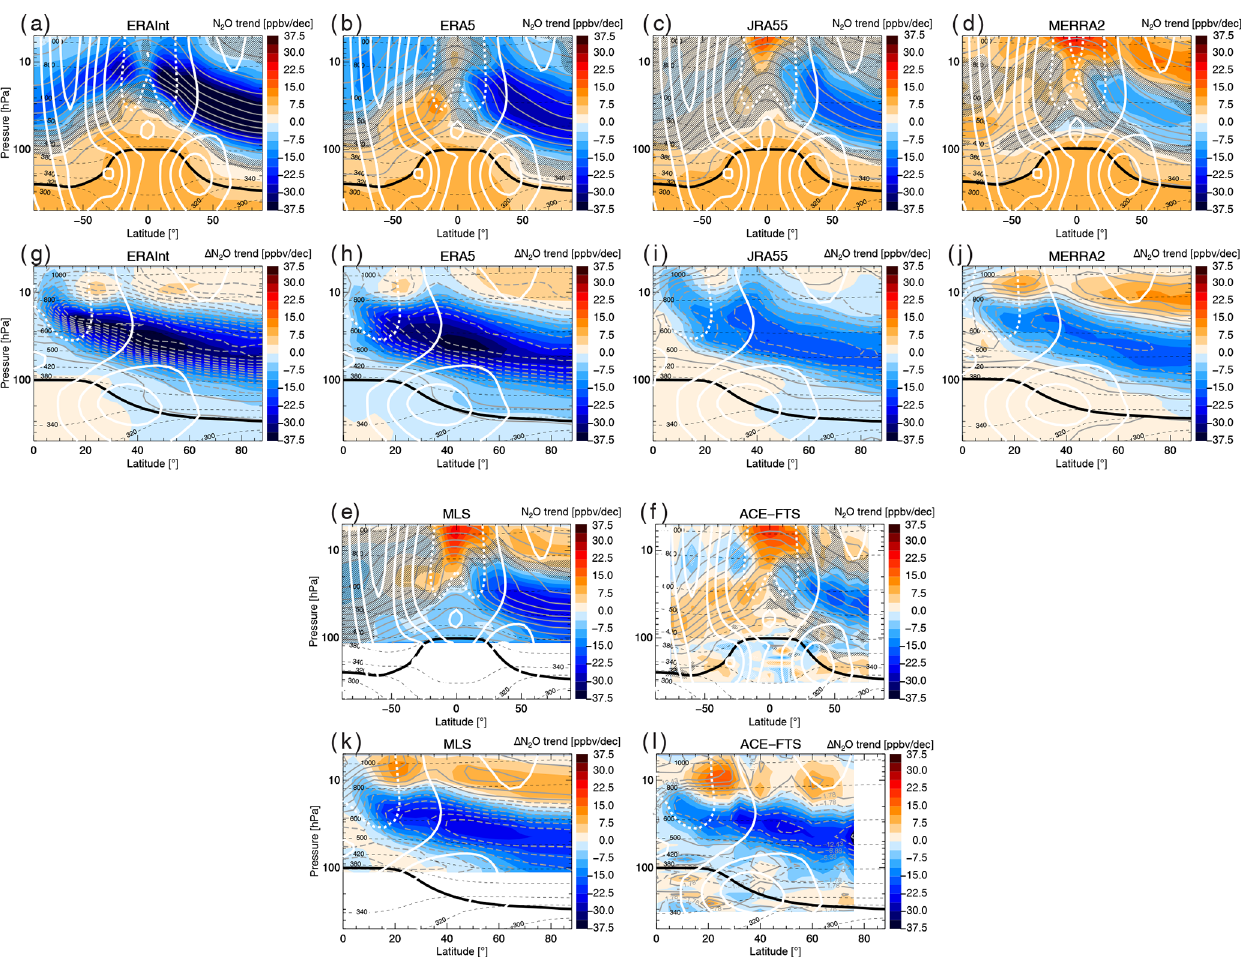
Figure 2. (a–d) Nitrous oxide trends for the period 2005–2017 for ERA5, ERA-Interim, JRA55 and MERRA2 and from satellite measure- ments by the (e) MLS and (f) ACE-FTS instruments. (g–j) Hemispheric difference in nitrous oxide trends (NH minus SH) for the different reanalyses and for (k) MLS and (l) ACE-FTS. Grey lines show climatological N 2 O (a–f) and the NH trend values ( g–l ; solid for positive, dashed for negative values), white lines show zonal wind contours (solid for positive, dashed for negative values), thin dashed black lines show potential temperature levels, and the thick black line shows the WMO tropopause. Regions where trends are not significant are hatched (i.e. where trend values are below 2 σ , with σ being the standard error of the linear